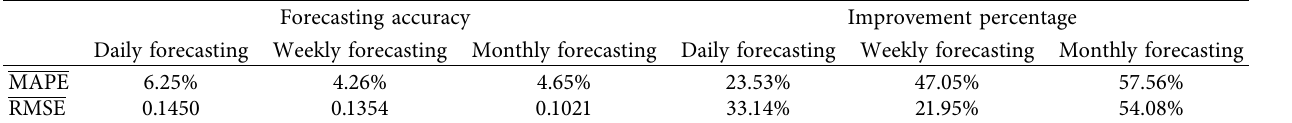
Table 6: Predictive performance of hybrid LSTM-EL over three time